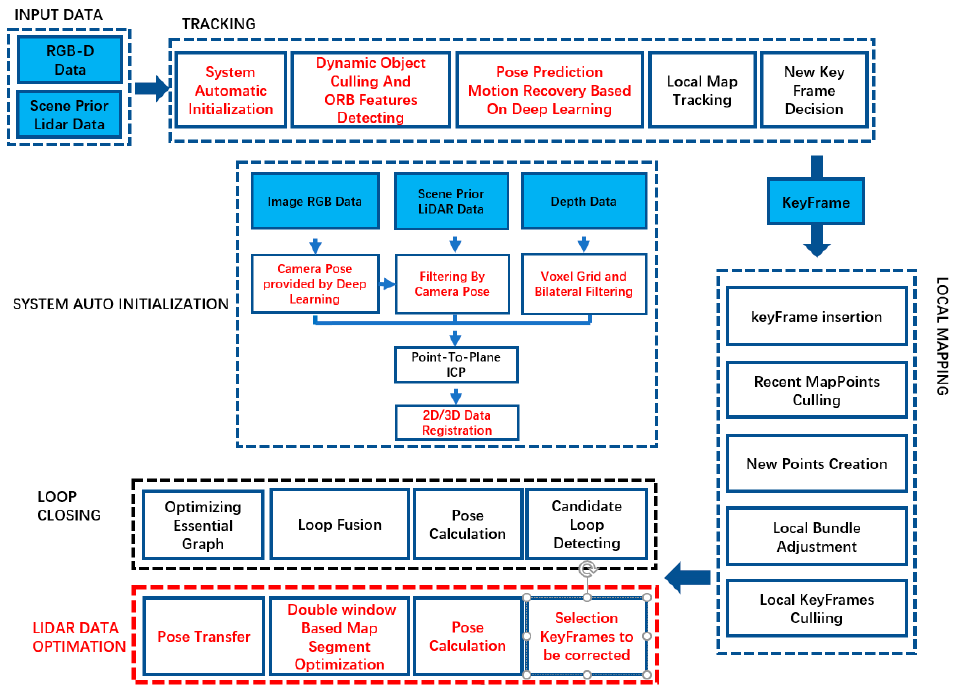
Figure 1. Flowchart of the proposed Light Detection and Ranging (LiDAR)-guided RGB and depth (RGB-D) simultaneous localization and mapping (SLAM).